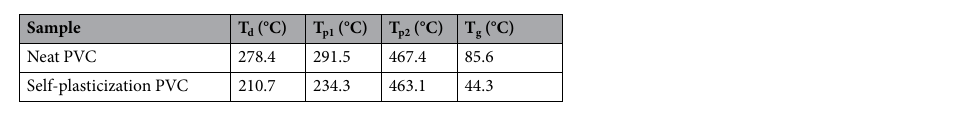
Table 2. Thermal properties of PVC materials. T d : Thermal degradation temperature. T p1 : Peak 1 temperature of thermal degradation. T